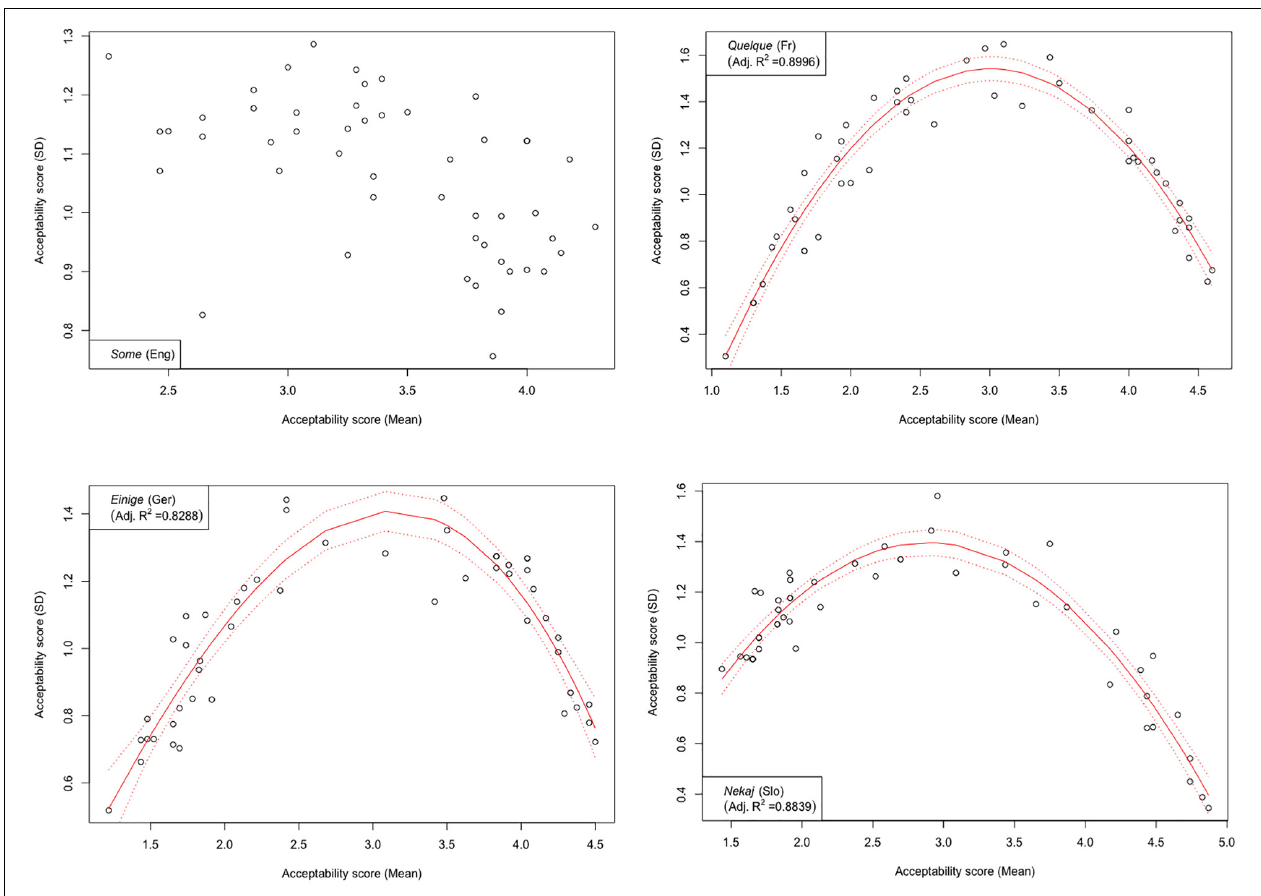
FIGURE 7 | Experiment 1: Standard deviation in the collected score data vs. mean score (both in units on a Likert scale). Each graph represents the results on quantifier some and its cross-linguistic variants. Also shown are best (quadratic) fit lines, confidence interval, and the coefficient of multiple determination R 2 .